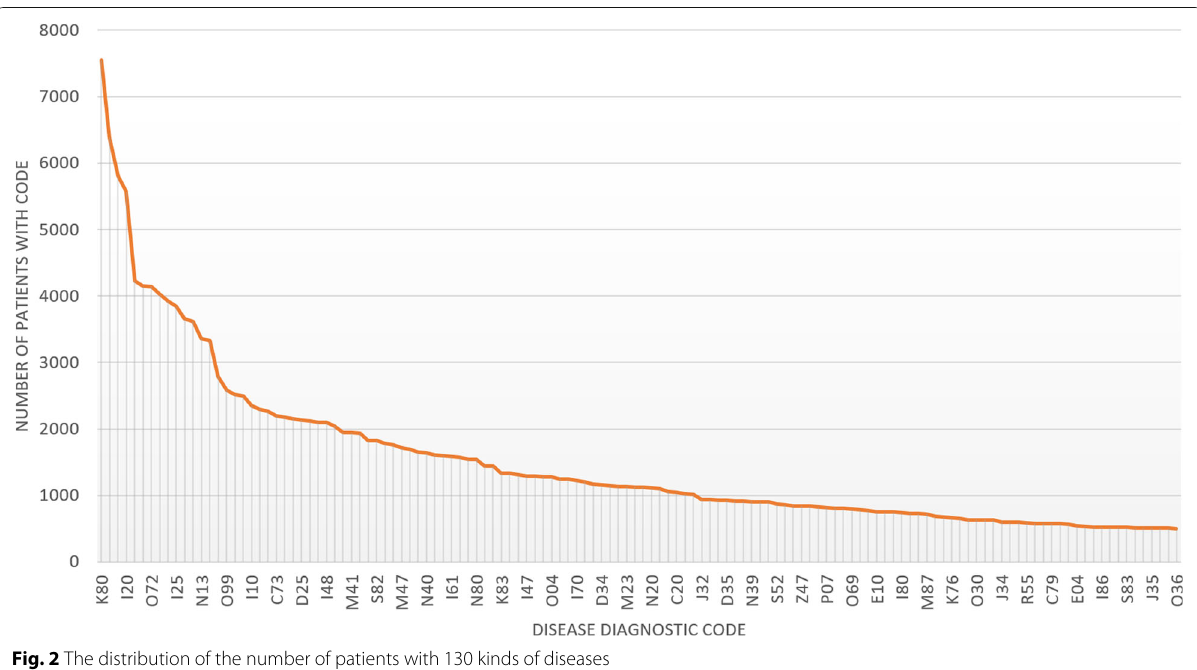
Fig. 2 The distribution of the number of patients with 130 kinds of diseases